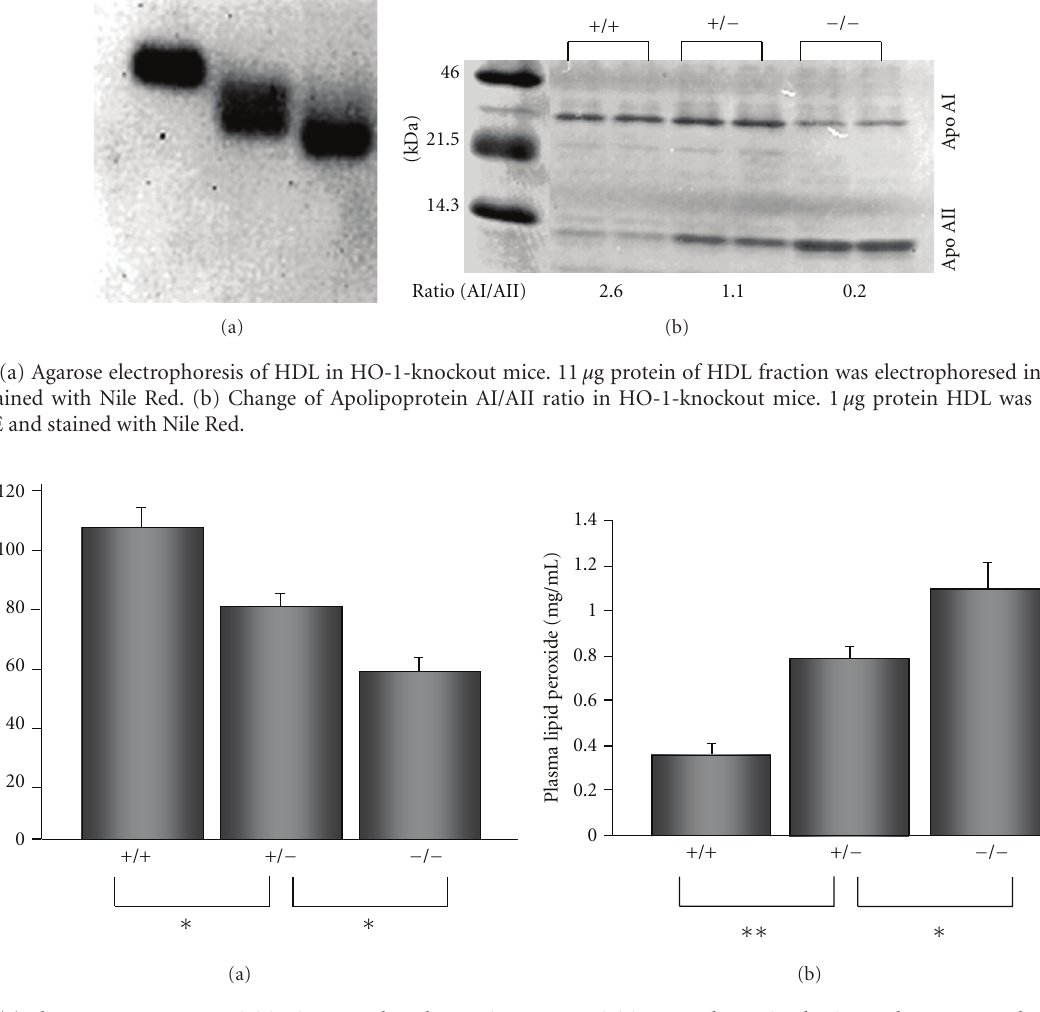
Figure 3: (a) Plasma paraoxonase activities in HO-1-knockout mice. PON activities were determined using arylesterase as substrate and are given as a percentage ± S.D. (b) Plasma lipid hydroperoxide levels in HO-1-knockout mice. Estimates of lipid peroxidation products were obtained by malondialdehyde (MDA) measurements of plasma. Data represents mean ± S.D. from duplicate. Asterisks represent statistically significant di ff erences ( ∗ P < 0 . 05, ∗∗ P < 0 .